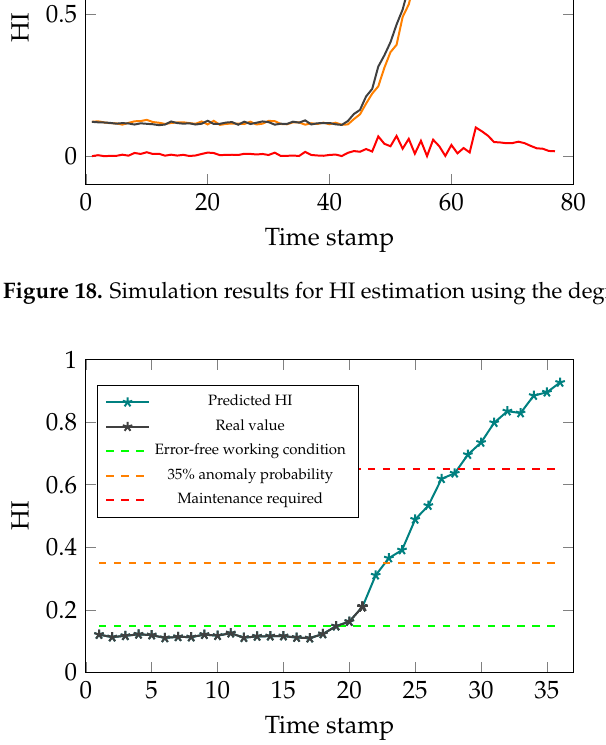
Figure 19. Simulation results for RUL